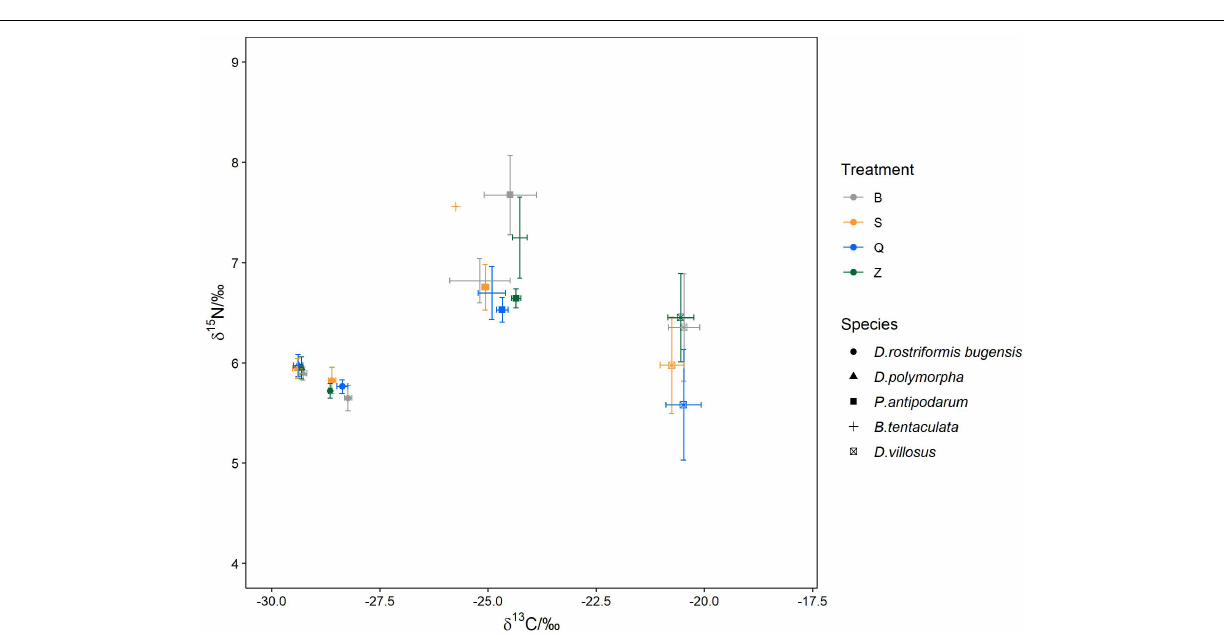
FIGURE 4 | The stable isotope bi-plots ( δ 13 C and δ 15 N) of five main newly settled macroinvertebrates in four different treatments. Error bars indicate standard